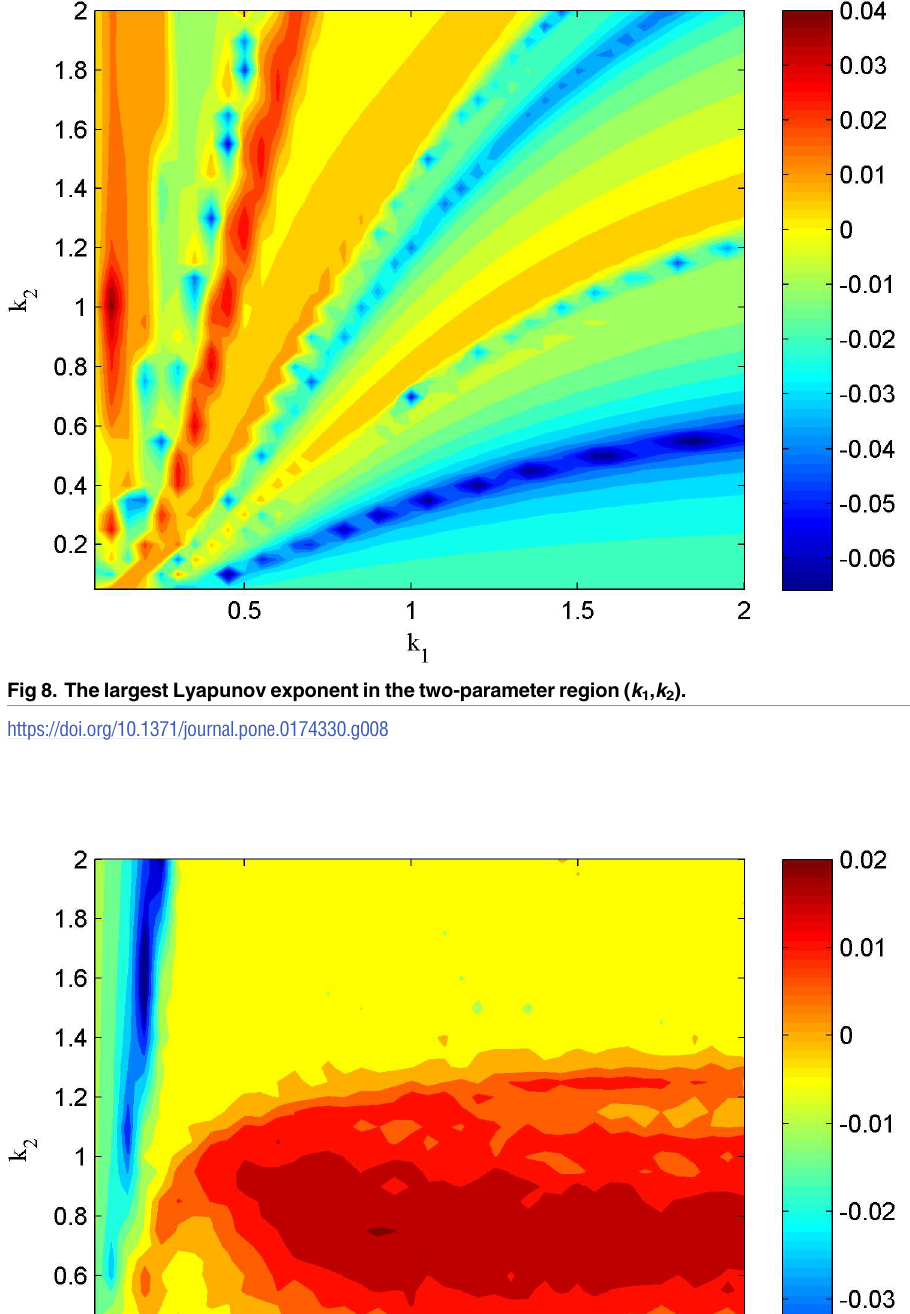
PLOS ONE | https://doi.org/10.1371/journal.pone.0174330 March 30,